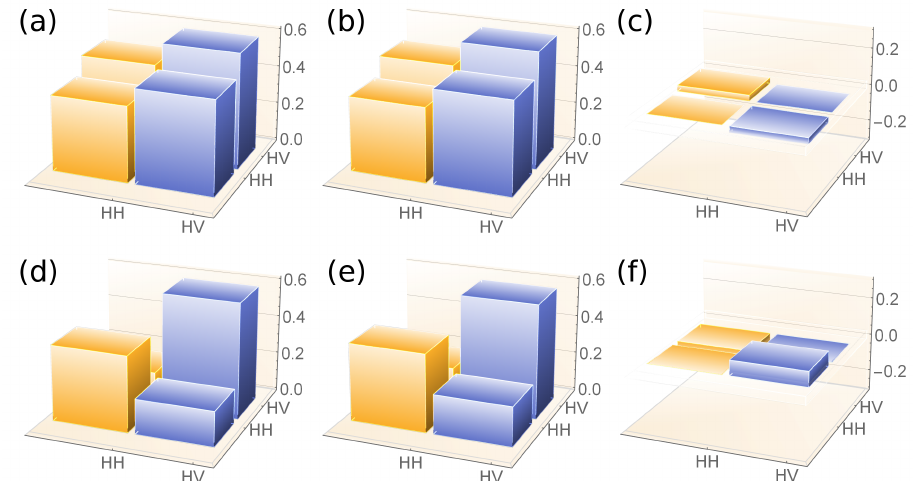
Figure 3. Density matrix reconstructions for the state outgoing the measurement process, considering an initial polarization (cid:12) (cid:69) 17 (cid:12) π state : ( a ) theoretical real part Re [ ρ in ] of the initial state density matrix (Im [ ρ in ] = 0); ( b , c ), respectively: the (cid:12) 60 ] ) and imaginary (Im [ ρ rec ] ) parts of the density matrix of the single-photon state after the reconstructed real (Re [ ρ rec PM PM protective measurement; ( d ) theoretically expected real part Re [ ρ dec ] of the density matrix of our state at the end of the ] ) and imaginary (Im [ ρ rec ] ) parts of projective measurement (Im [ ρ dec ] = 0); and ( e , f ), respectively: reconstructed real (Re [ ρ rec PJ PJ the density matrix of the single-photon state after undergoing the projective